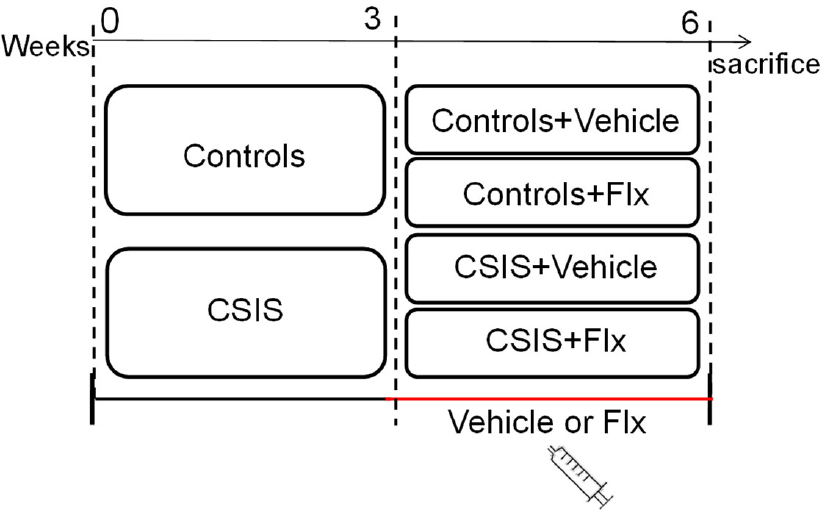
Figure 4. Schematic representation of the study design. CSIS–Chronic Social Isolation; Flx ‐ fluoxetine.